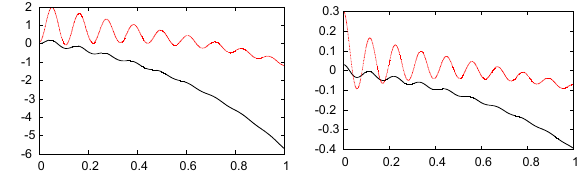
Fig. 5. Aeroelastic response in terms h ( t ) (on the left) and α ( t ) (on the right) for U = 40 m / s in dependence on the value of the initial displacement of α (0).